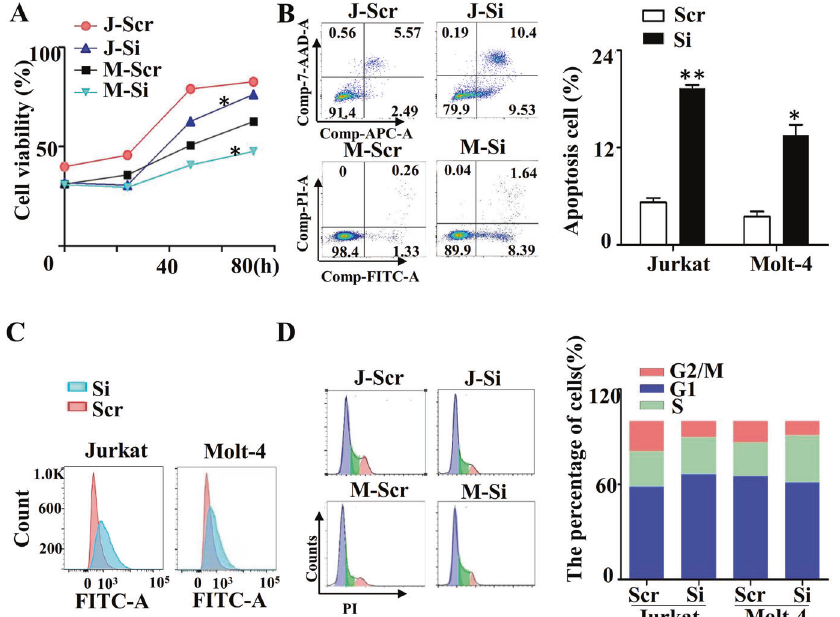
Fig. 1 The role of miR-652-5p in T-ALL cells. Effect of impaired miR-652-5p on ( A ) growth by CCK-8 assay, ( B ) apoptosis by Flow cytometry, ( C ) ROS by Flow cytometry, and ( D ) cell cycle by Flow cytometry. Abbreviation : h, hours; J, Jurkat cell lines; M, Molt-4 cell lines; Scr, control; Si, impaired miR-652-5p. p is compared to control and calculated by t student; * p < 0.05; ** p <